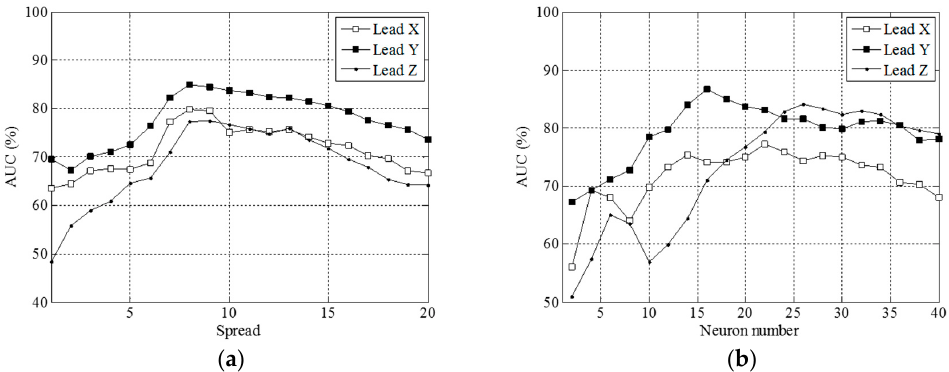
Figure 6. Graphs of ( a ) AUC vs. the spread parameters, keeping the neuron number fixed at 20; and ( b ) of AUC vs. the neuron number, keeping the spread parameter fixed at 10. As indicated, Figure 6a,b give maximum values of 79.8%, 85.0% and 77.5% at σ = 8, 8 and 9 with M = 20 in the X, Y and Z leads, and of 77.3%, 86.7% and 84.1% at M = 22, 16 and 26 with σ = 10, respectively. We found AUC decreased with σ and M when it went beyond a certain threshold.